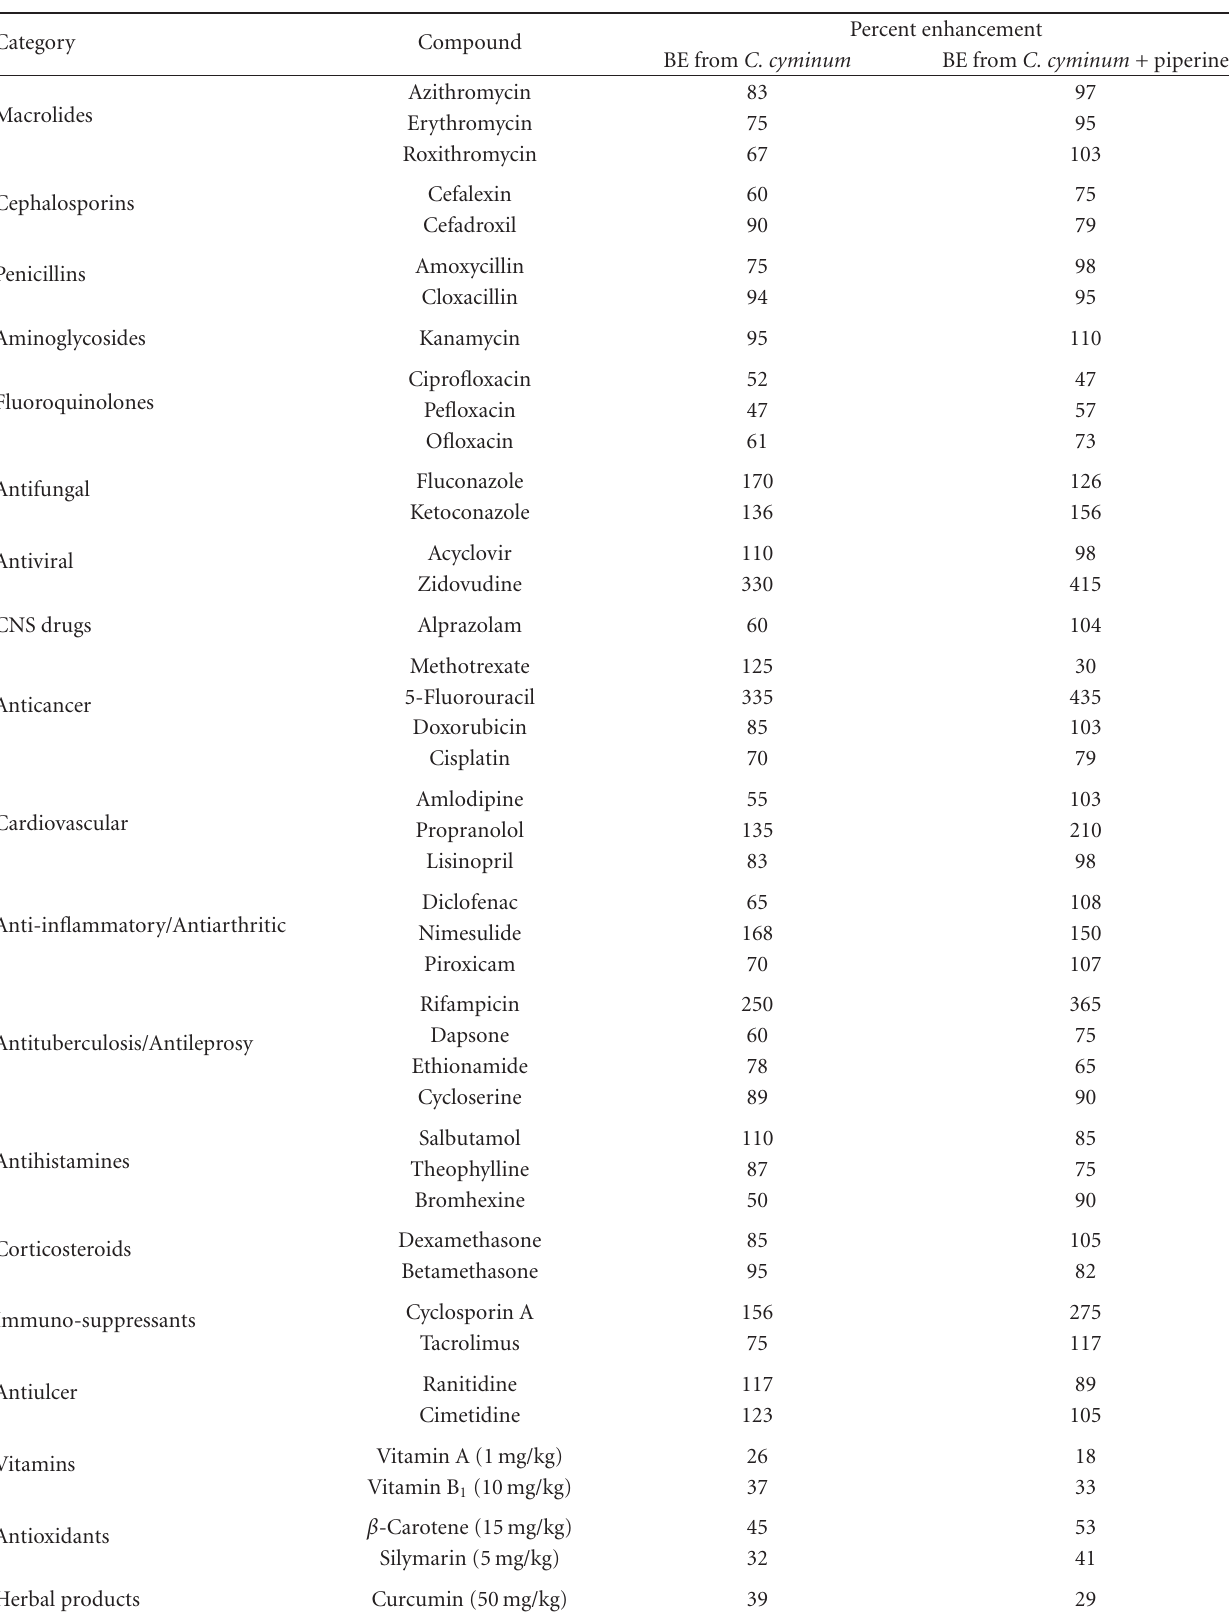
Table 23: Percent enhancement in bioavailability of di ff erent compounds by supplementation of bioactive fractions from C. cyminum and its combination with piperine [166,